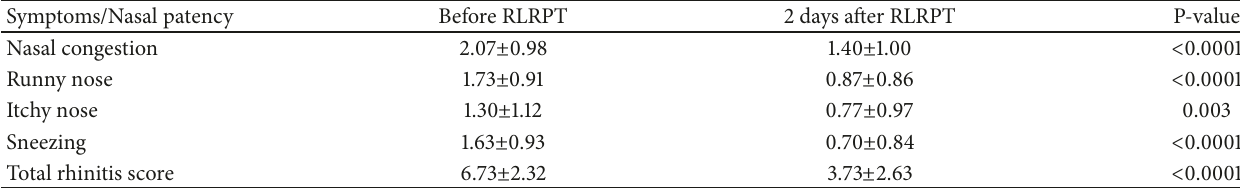
Table 3: Comparison before and 2 days after medical treatment in the control